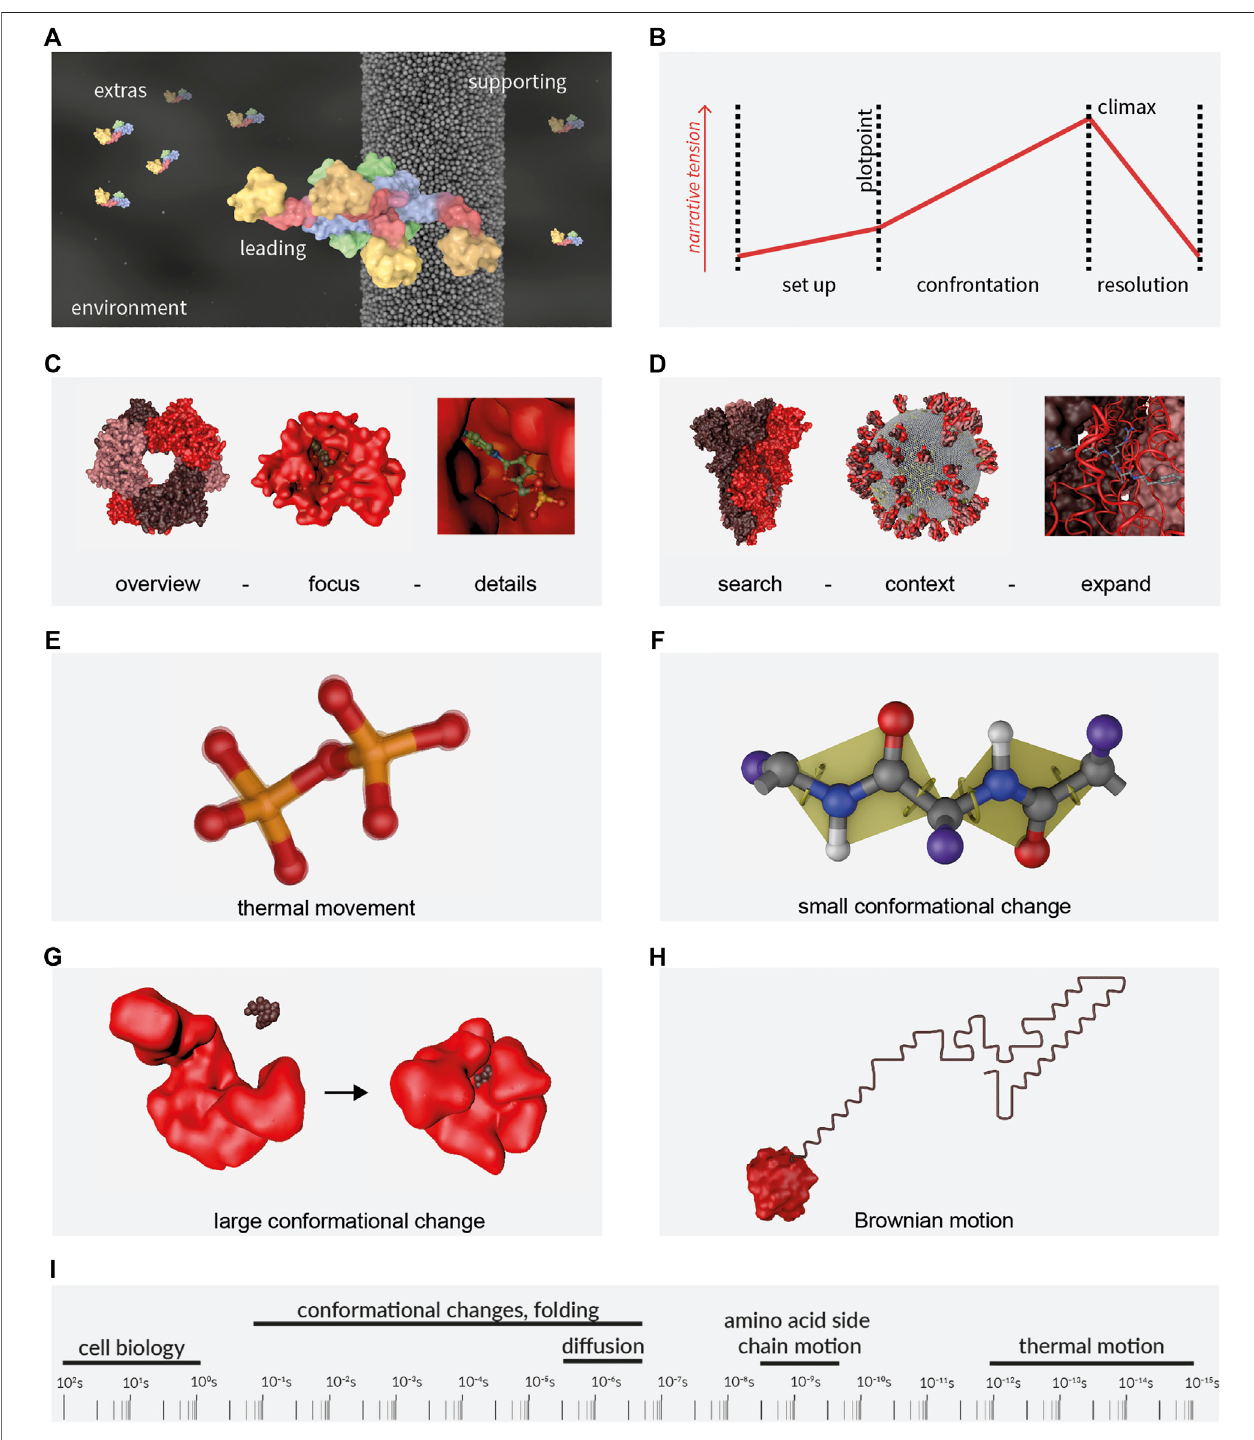
FIGURE 1 | Storytelling and motion. (A) Molecular Actors. (B) Molecular Storytelling. The three stages of a classical story. Presentation Order, (C) overview fi rst (hexamer in the example), zoom (monomer with ligand) and fi lter (ligand details); and (D) search (spike protein), show context (whole virus), expand (detail of the spike protein hinge region). Visualisation of the movement in/of macromolecules: (E) thermal movement (F) small and (G) large conformational changes and (H) Brownian motion. (I) Timescales of biological processes. Molecules depicted are: (A) Dynamin1, PDB code 3SNH, (Faelber et al., 2011); (C) and (H) NMNAT1, PDB code 1GZU (Werner et al., 2002); (D) SARS-CoV-2 proteins S [PDB code 1KDI, (Gobeil et al., 2021)], E [PDB code 7K3G (Mandala et al., 2020)], M by Mahtarin et al. (2020) and Swiss-Model entries for P0DTC4; (G) Adenylat Kinase, PDB codes 4AKE (Müller et al., 1996) and 2ECK (Berry et al., 2006). PDB: Protein Database (Berman et al., 2000); Swiss-Model Repository (Bienert et al.,